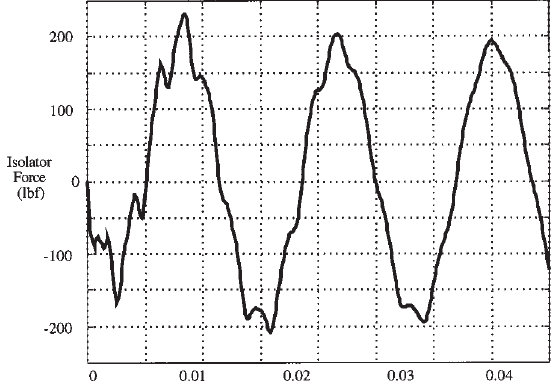
Fig. 6. Comparison of synthesis ( (cid:16) = 0) with Direct FE: Isolated mass vertical response vs time. Fig. 7. Synthesis ( (cid:16) = 0): nonlinear isolator force vs